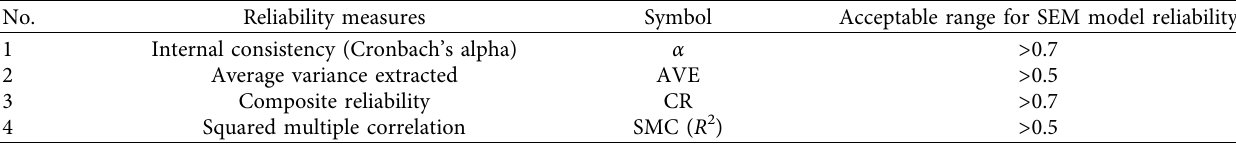
Table 6: Acceptable values for evaluation of model reliability (source: [32].